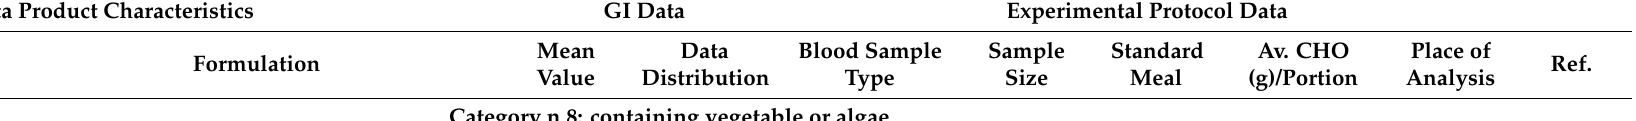
Table 1. Pasta product characteristics, glycemic index and experimental protocol data.